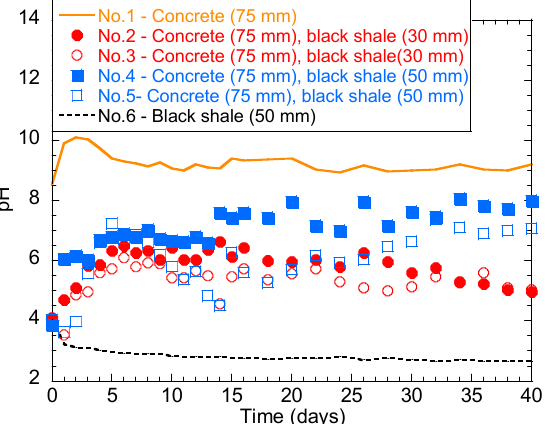
Figure 3. Temporal behavior of the solution pH during the laboratory immersion tests.